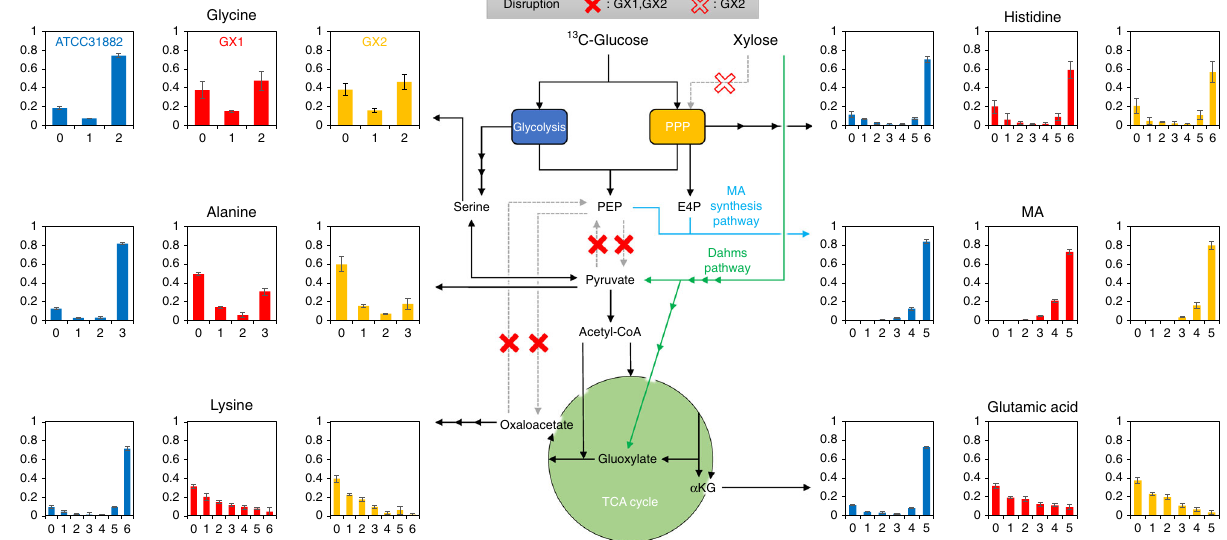
Fig. 6 13 C-metabolic analysis. Blue, red, and yellow bars indicate the mass isotopomer distributions of six metabolites [glycine, alanine, lysine, histidine, glutamic acid, and cis,cis -muconic acid (MA)] from tracer experiments with [U- 13 C]glucose and non-labeled xylose in ATCC31882xMA, GX1xMA, and GX2xMA, respectively. The vertical axis indicates the relative abundance. The horizontal axis is M + , which denotes the difference with a fully unlabeled isotopomer regarding the m / z of a mass fragment (fully unlabeled isotopomer, M + = 0). The maximum value of M + for each metabolite is the number of constituent carbons of the metabolite in the mass fragment. Red closed crosses indicate disrupted metabolic pathways in the GX1 and GX2 strains. Red open cross indicates the disrupted metabolic pathway in the GX2 strain. G6P glucose-6-phosphate; PEP phosphoenolpyruvate; E4P erythrose 4-phosphate; and α KG alpha-ketoglutarate. The data are presented as the average of three independent experiments, and error bars indicate standard errors. Source data are provided as a Source Data fi